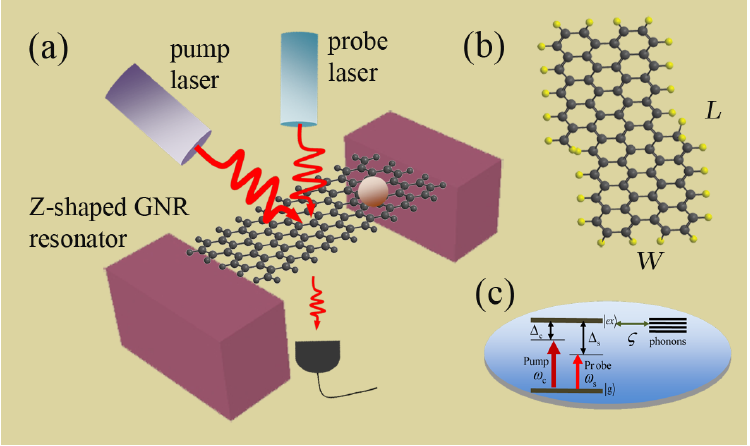
( a ) Schematic diagram of a doubly-clamped Z-shaped graphene nanoribbon (GNR) resonator system with the optical pump-probe scheme; ( b ) Atomic structure of the Z-shaped GNR; ( c ) The exciton energy levels in the Z-shaped GNR coupled to the resonator. If NH and NO molecules are deposited onto the surface of the resonator, their mass can be 3 2 determined immediately by the frequency shift of the nonlinear optical